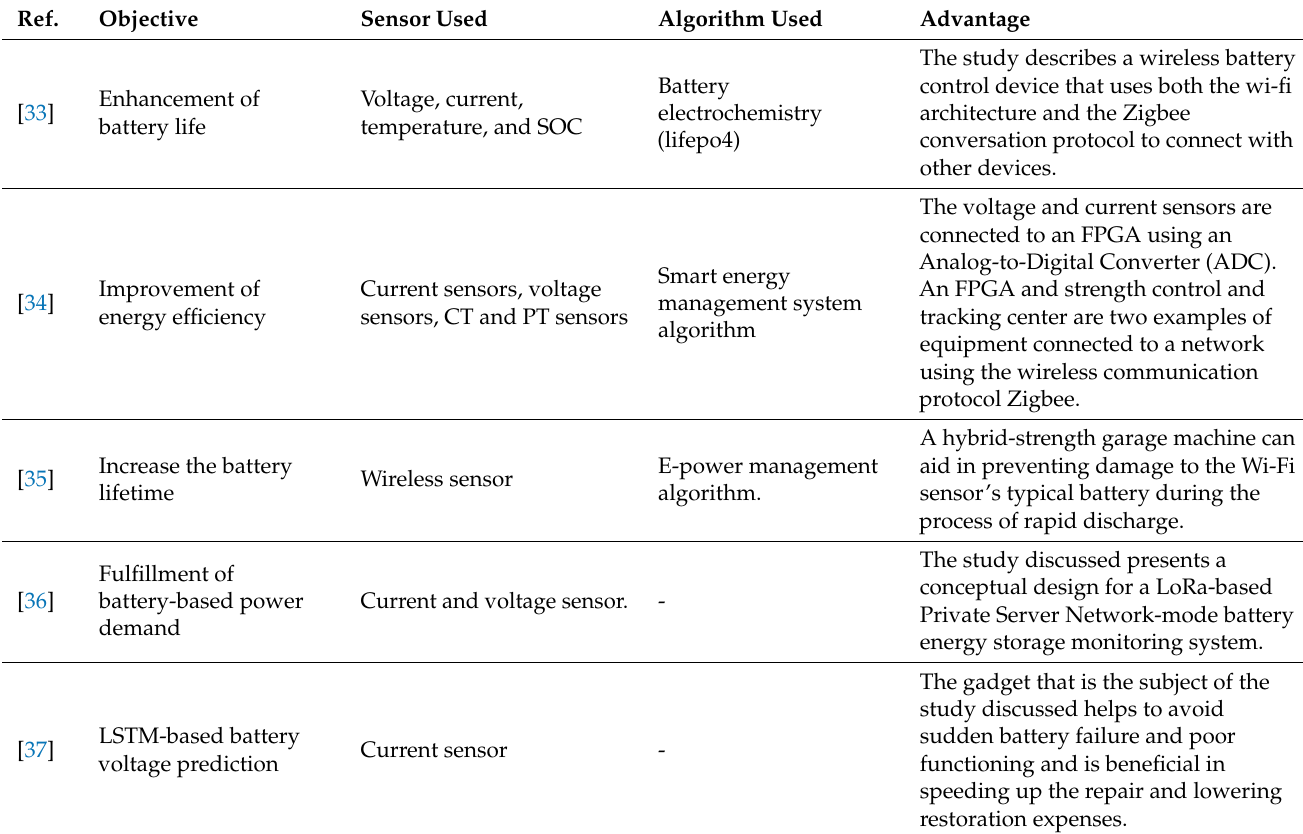
Table 2. A detailed survey of WSN in battery-management